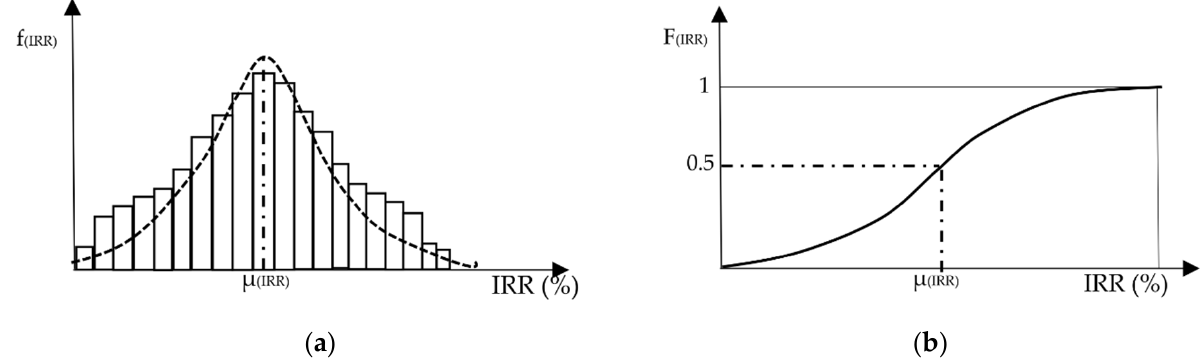
Figure 4. ( a ) Example of IRR punctual probability distribution; ( b ) Example of IRR cumulative probability distribution.